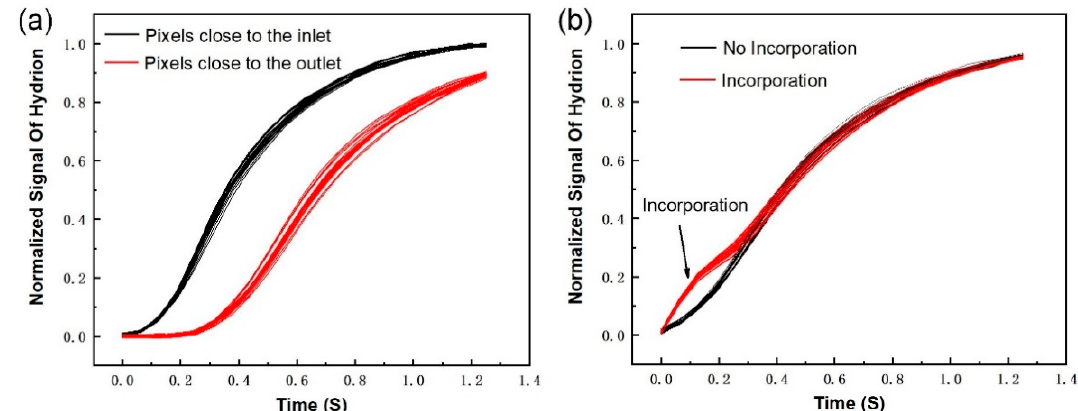
Figure 10. ( a ) When there were no chemical reactions, the pixels only output the background signals. The pixels represented by the black curves were closer to the inlet than the pixels represented by the red curves. ( b ) The distinct red signal bumps that are indicated by the arrow, demonstrate that the chemical reactions to the DNA base pairing have occurred. The DNA base pairing chemical reaction can be detected by the sensor array chip.